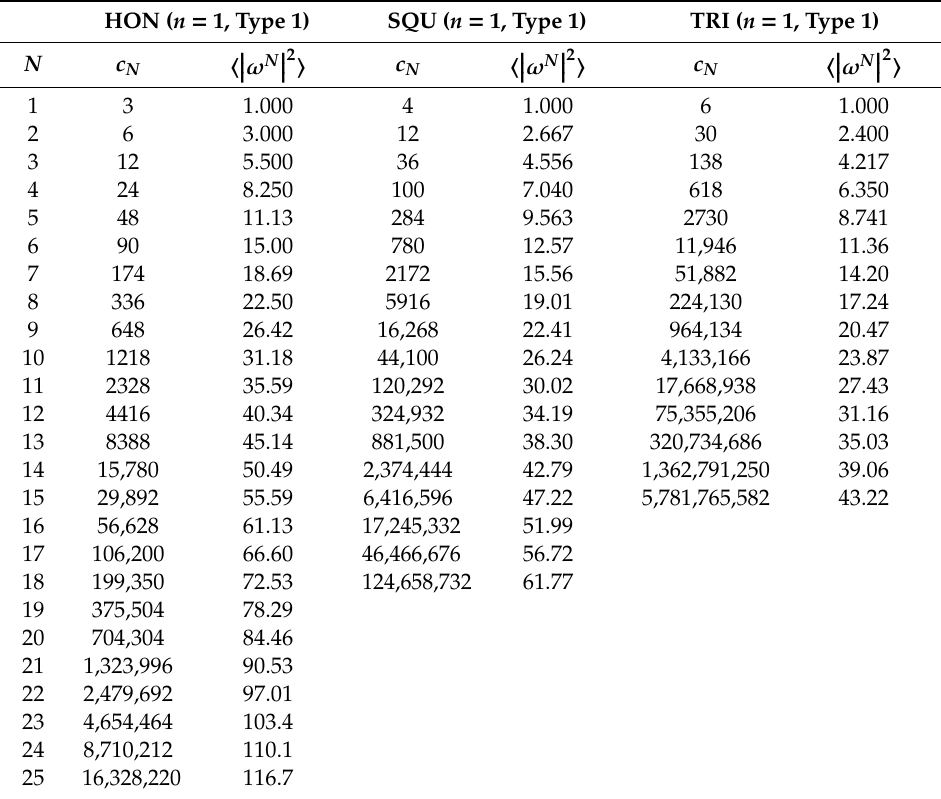
Table A1. Properties of SAWs on 2-D regular lattices corresponding to extreme, plate-like confinement: honeycomb (HON), square (SQU) and triangular (TRI). In all cases n = 1 and Type